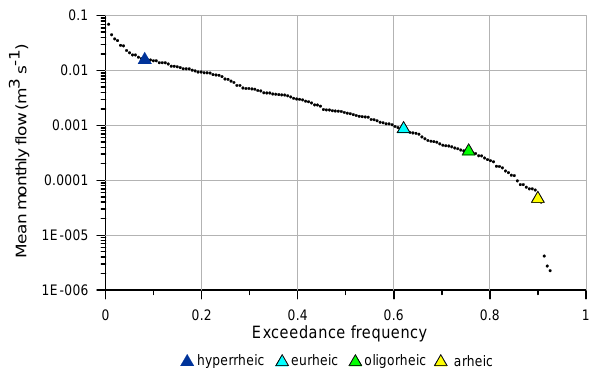
Fig. 4. Hydrograph and aquatic states during the 2010 biological sampling campaign at Vallcebre, Can